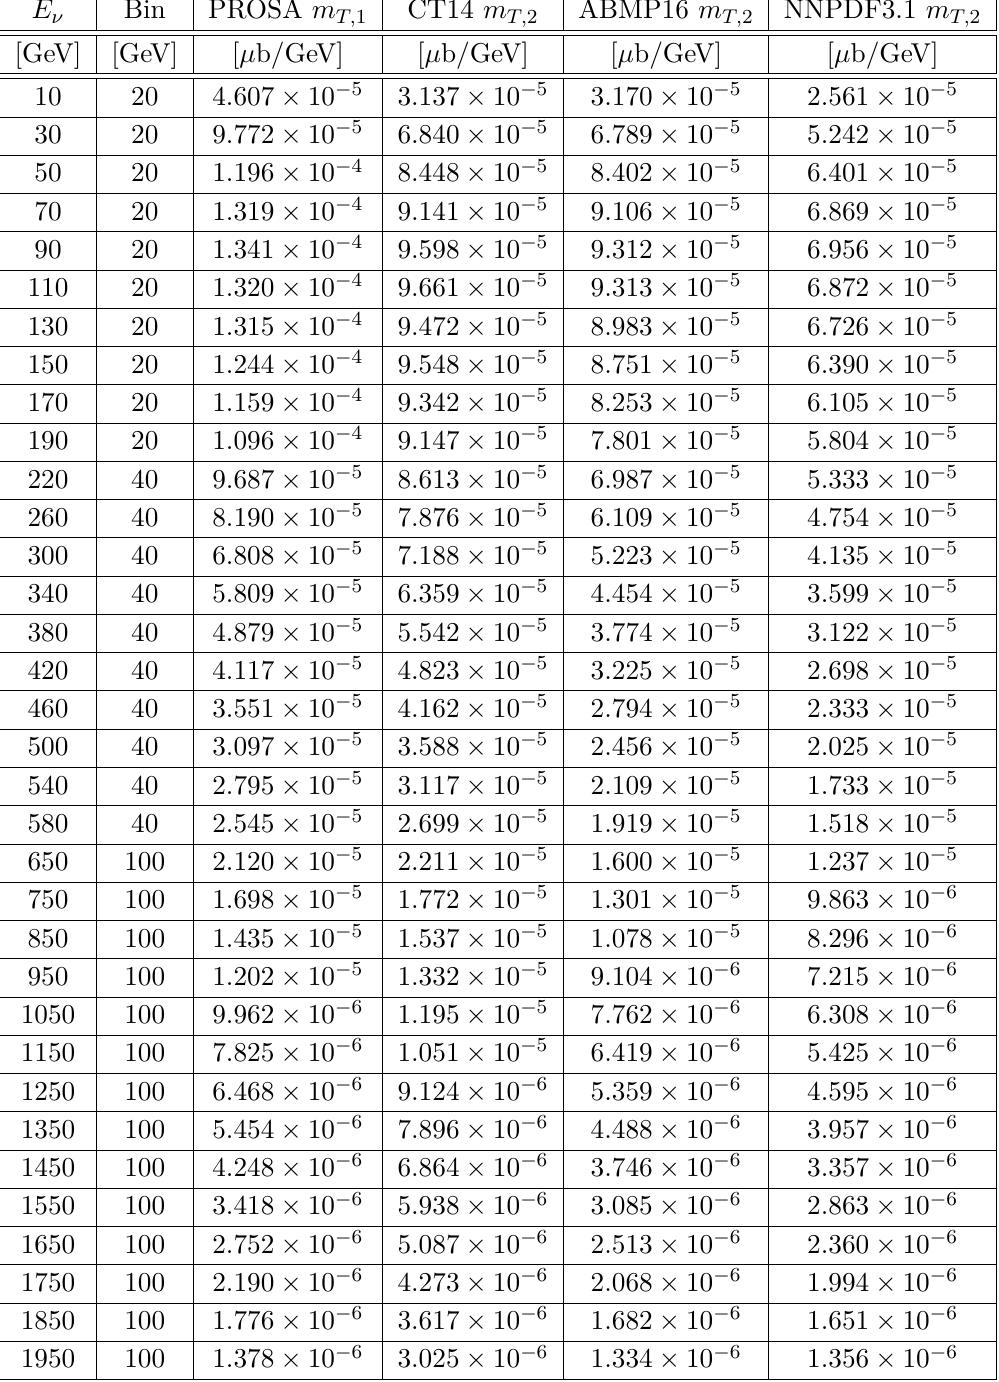
√ for s = 14 TeV, η ν > 8 . 9 . s